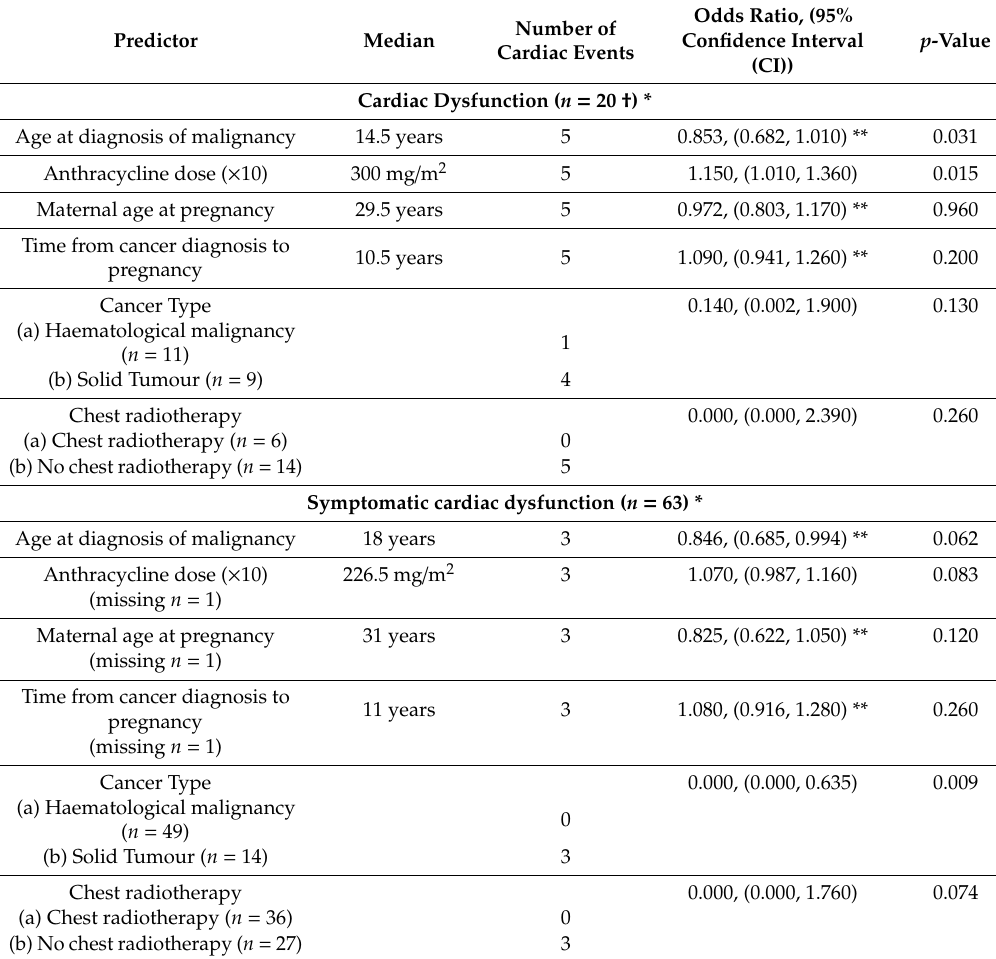
Table 3. Risk factors for pregnancy-related cardiac events first live births